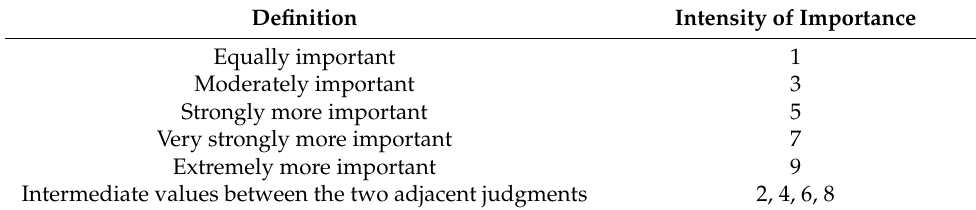
Table 1. Index comparison importance level